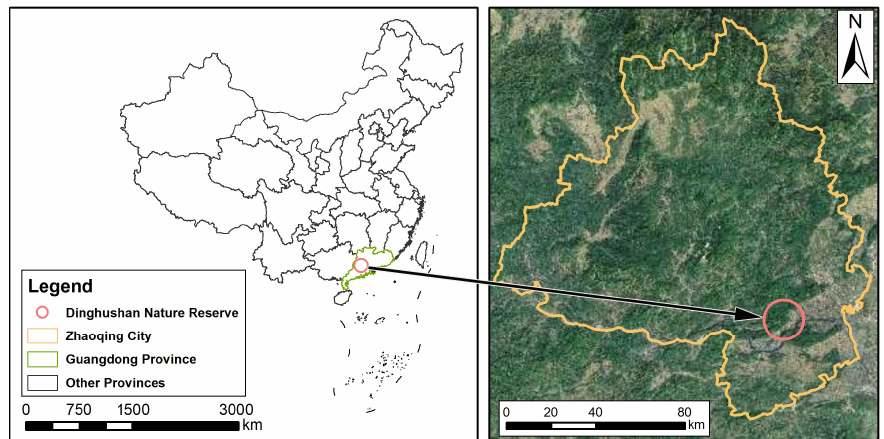
Figure 1. Location of the tower crane plot in Dinghushan Nature Reserve, China.